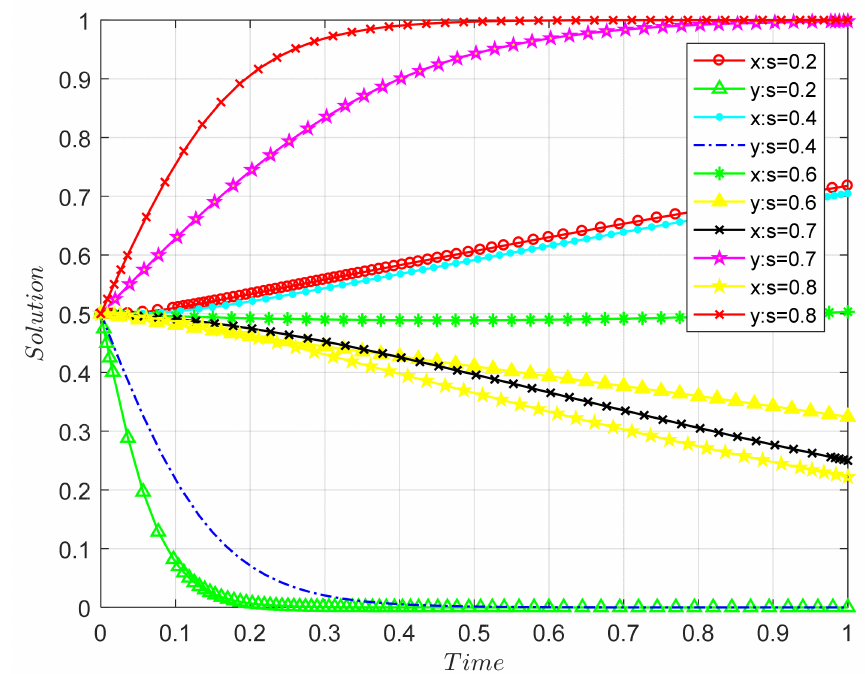
Figure 7. The influence of the government subsidy rate s on the dynamic evolution of the two parties in the